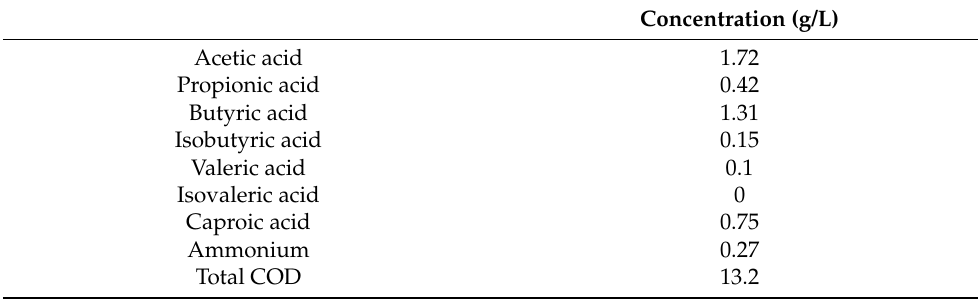
Table 1. The content of volatile fatty acid (VFA) effluent obtained from acidogenic fermentation of food